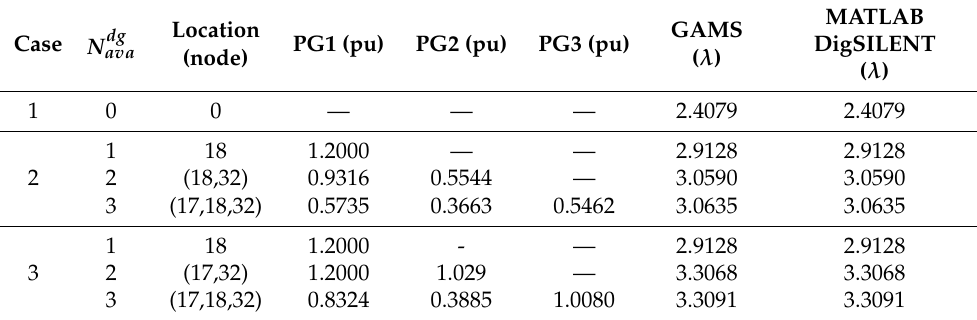
Table 4. Numerical performance of the λ -coefficient in the IEEE 33-bus system for all the simula- tion